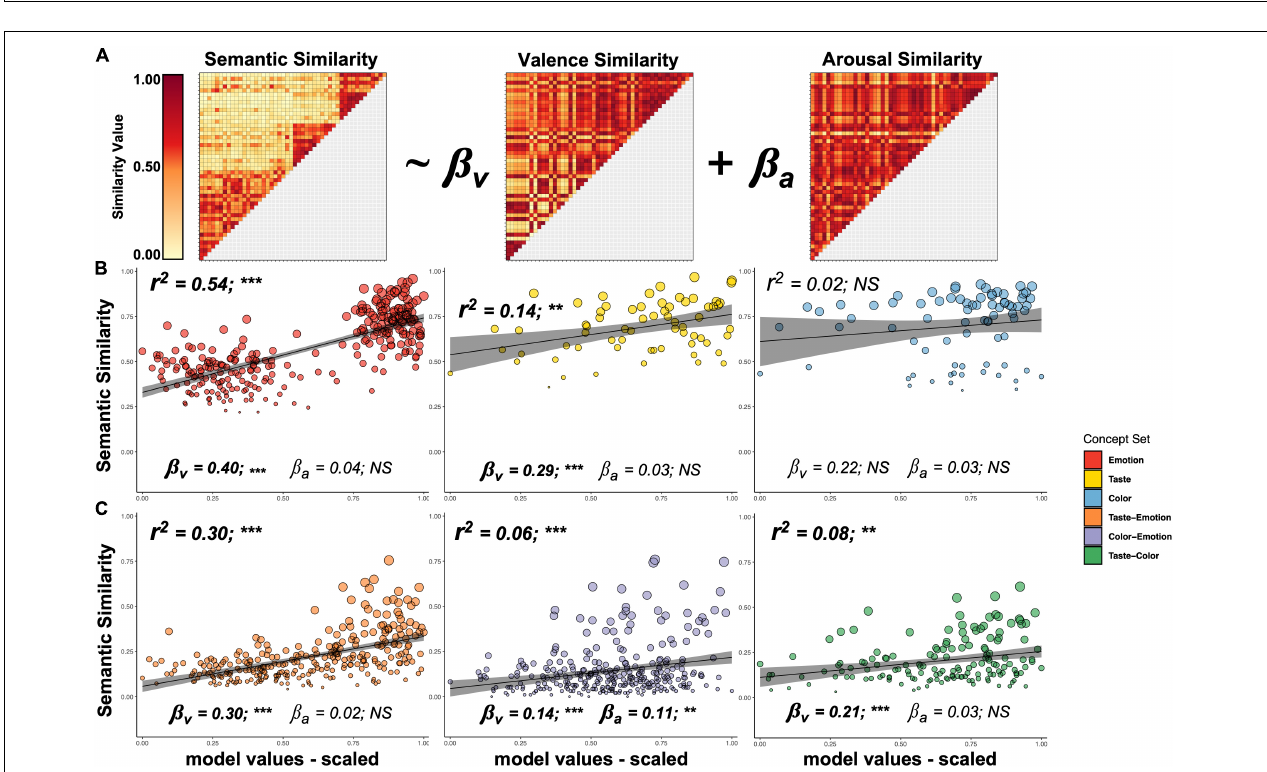
FIGURE 3 | Relationship between semantic similarity and similarity in valence and arousal. (A) We compared the pairwise semantic similarity between concepts to those concepts’ similarity in valence and arousal using a general linear model. (B) The similarity of Emotion and Taste concepts by themselves, but not Color concepts, was related to their similarity in hedonic valence. (C) This relationship with valence was also present in the similarity of Taste–Emotion, Color–Emotion, and Taste–Color concept pairs. β v , beta-coefficient for valence similarity; β v , beta-coefficient for arousal similarity. ∗∗∗ p < 0.001; ∗∗ p < 0.01; NS p > 0.05.